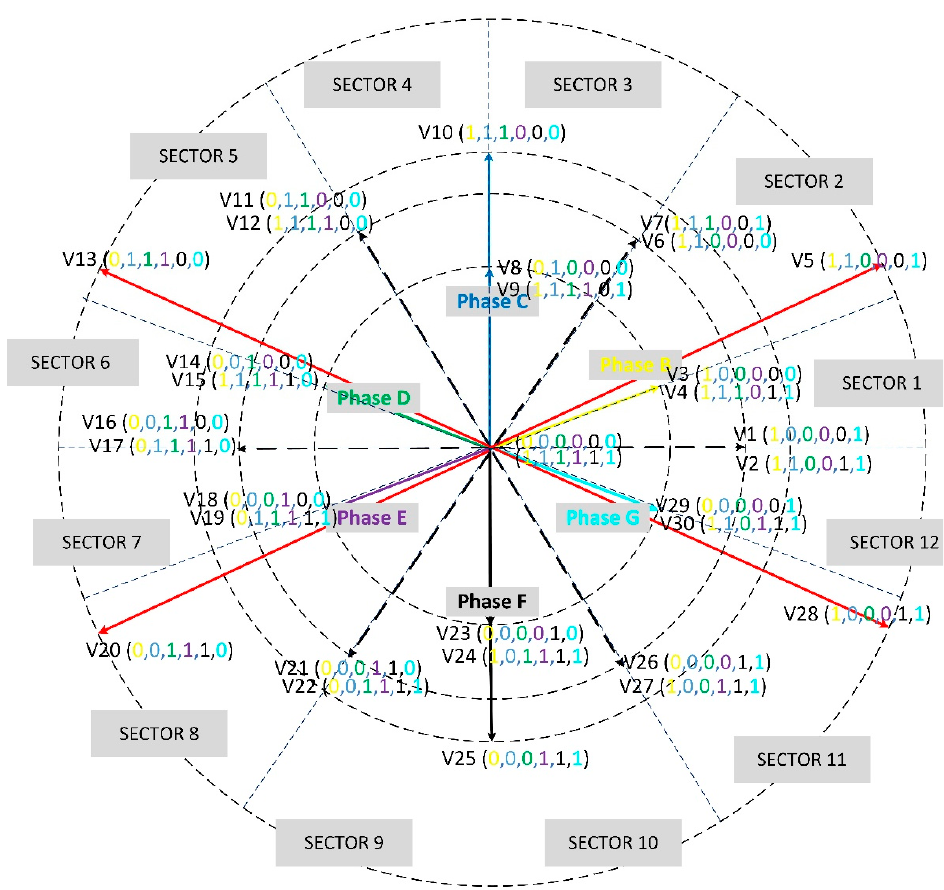
Figure 8. Space vector diagram of the seven-phase PMSM after losing phase ‘A’. The amplitude of the vectors whose arrows lies on the inner circle will be 0.2857* VDC, the amplitude of the vectors whose arrows lies on the next circle will be 0.4721*VDC, the amplitude of the vectors whose arrows lies on the third circle will be 0.4942*VDC. Finally, the vectors whose arrows lies one the outer circle will be 0.6039*VDC. It should be mentioned here that the vectors V5, V13, V20, and V28 (outer circle) are very close in direction to phase ‘B’, ’D’, ’E’, and ‘G’ respectively as the difference in angles between them is just 6.8 0 and hence, they will be approximated to be in the same direction in this paper (i.e., the direction of the phases ‘B’, ‘D’, ’E’, and ‘G’). The flowchart to implement the new SVPWM after losing phase ‘A’ in the seven ‐ phase drive is depicted in Figure 9. The illustration of each part of the flow chart is given below.